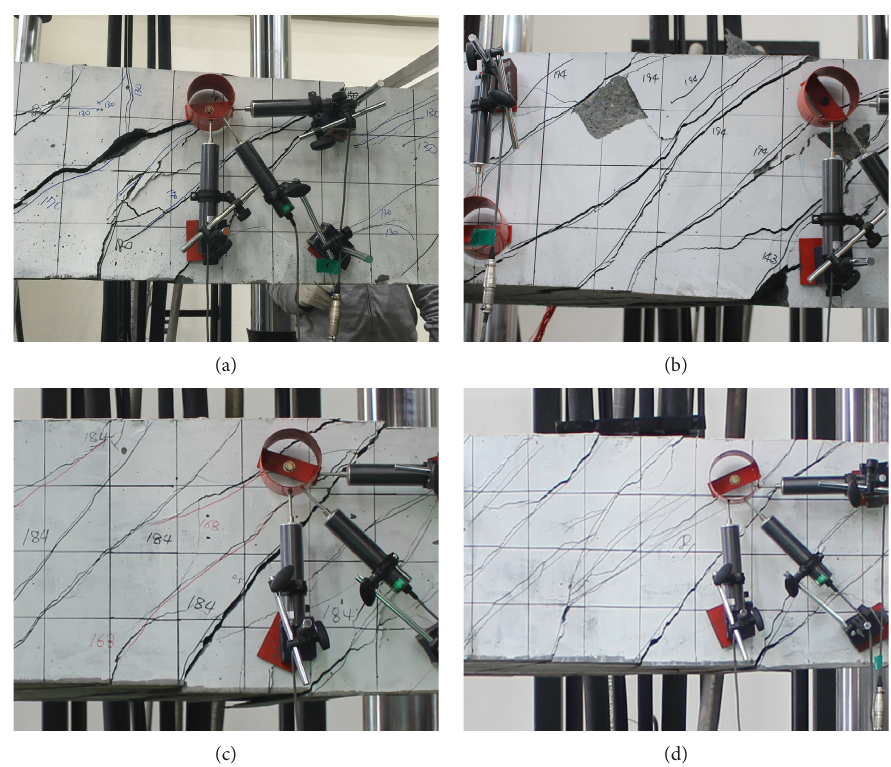
Figure 7: Behavior of the softening zone in specimens using high-strength reinforcement. (a) Series 3: RA-SD5-3.2-0.3-3.21 ( θ � 0.11rad/m, T � 48.6kN · m). (b) Series 3: RA-SD6-3.2-0.2-3.21 ( θ � 0.111rad/m, T � 64.2kN · m). (c) Series 6: RA-SD5-5.1-1.0-2.00 ( θ � 0.13 rad/m, T � 68.0kN · m). (d) Series 6: RA-SD6-5.1-0.9-2.00 ( θ � 0.14rad/m, T � 66.3kN · m).